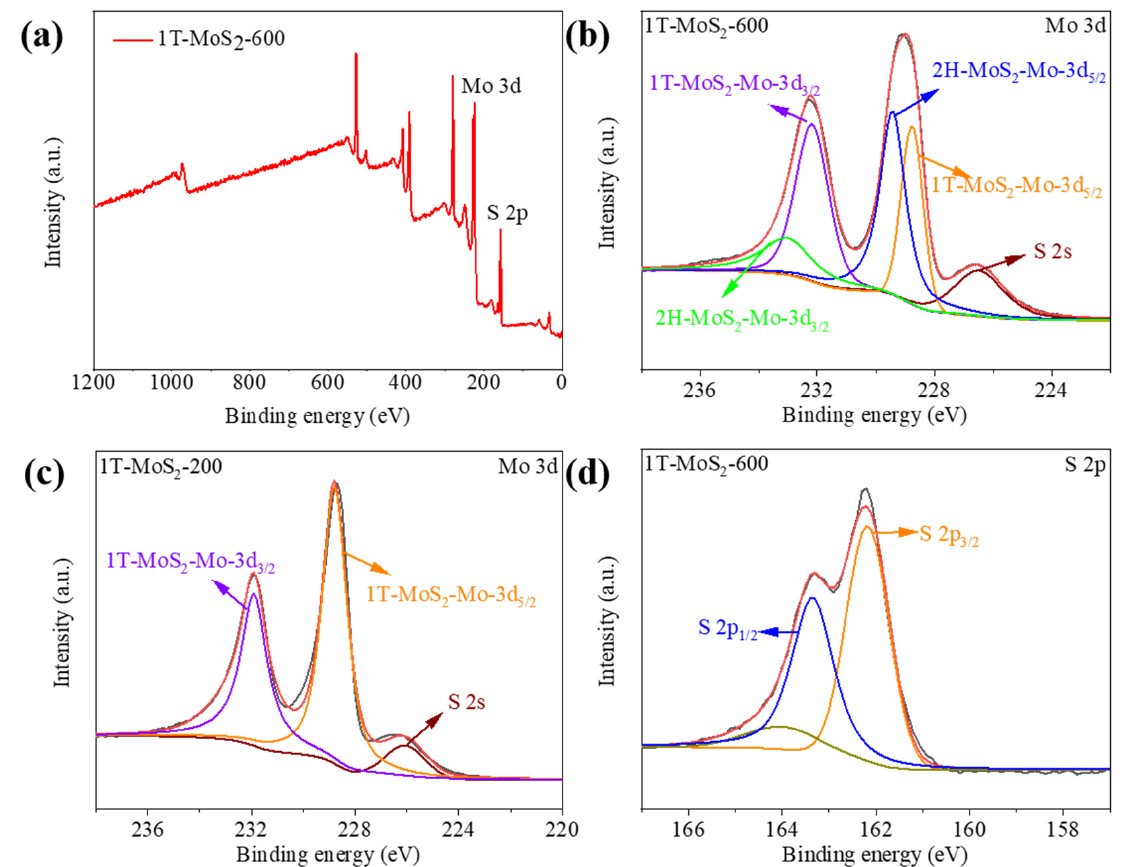
Figure 2. ( a ) XPS survey spectrum of 1T-MoS 2 -600, ( b ) Mo 3d spectrum of 1T-MoS 2 -600, ( c ) Mo 3d of 1T-MoS 2 -200, and ( d ) S 2p spectrum of 1T-MoS 2 -600.